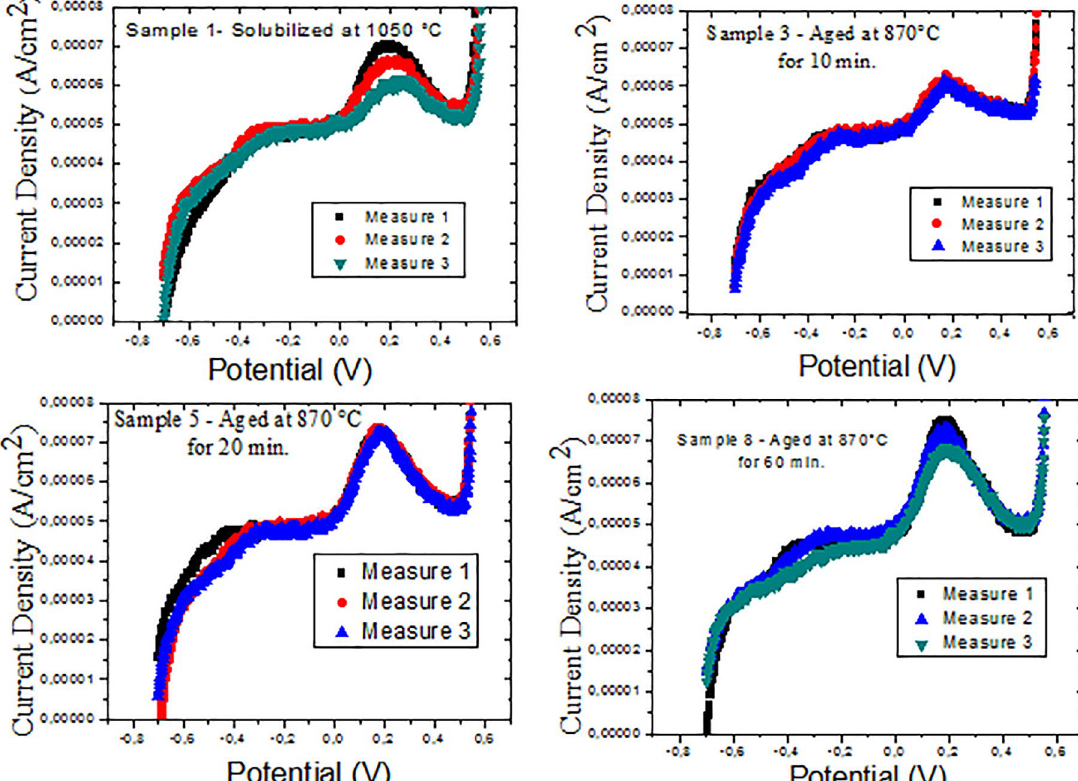
Figure 5. Linear Sweep Voltammetry of steel UNS S 31803 for different heat treatment conditions in 0.3 mol/L KOH solution and 2 mV/s of scan rate.